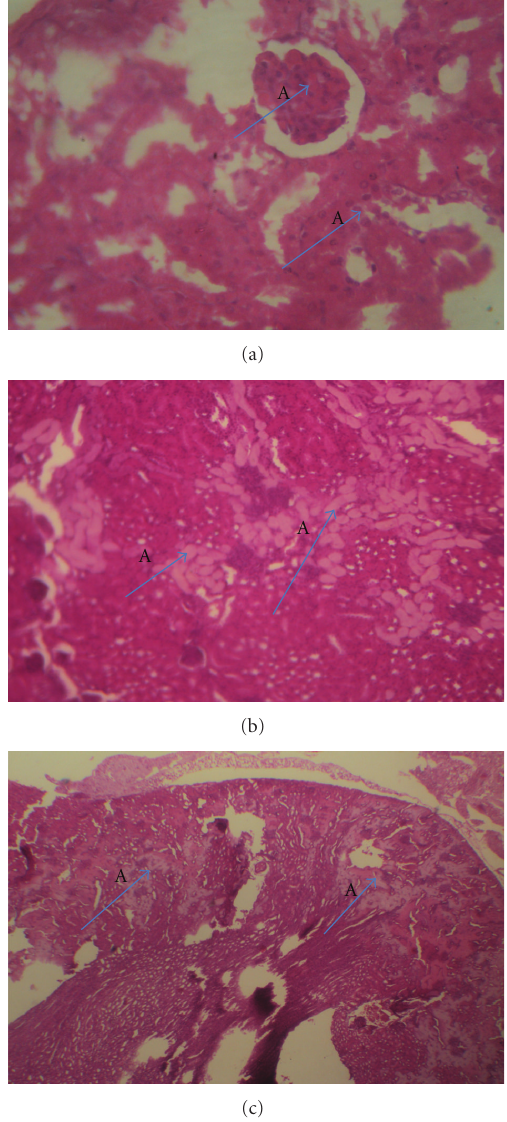
Figure 1: (a) The micrograph of the liver section obtained from first filial control rats, magnification × 400. (A) Hepatic central vein, (B) normal hepatocyte. (b) The micrograph of the liver section obtained from first filial rats treated with fixed-dose combined antituberculous agents, magnification × 400. (A) Hepatic necrosis, (B) hepatic central vein. (c) The micrograph of the liver section obtained from first filial rats treated with fixed-dose combined antituberculous agents plus vitamin C, mag × 40. (A) Hepatocytes with intracytoplasmic inclusions, (B) hepatic central veins.